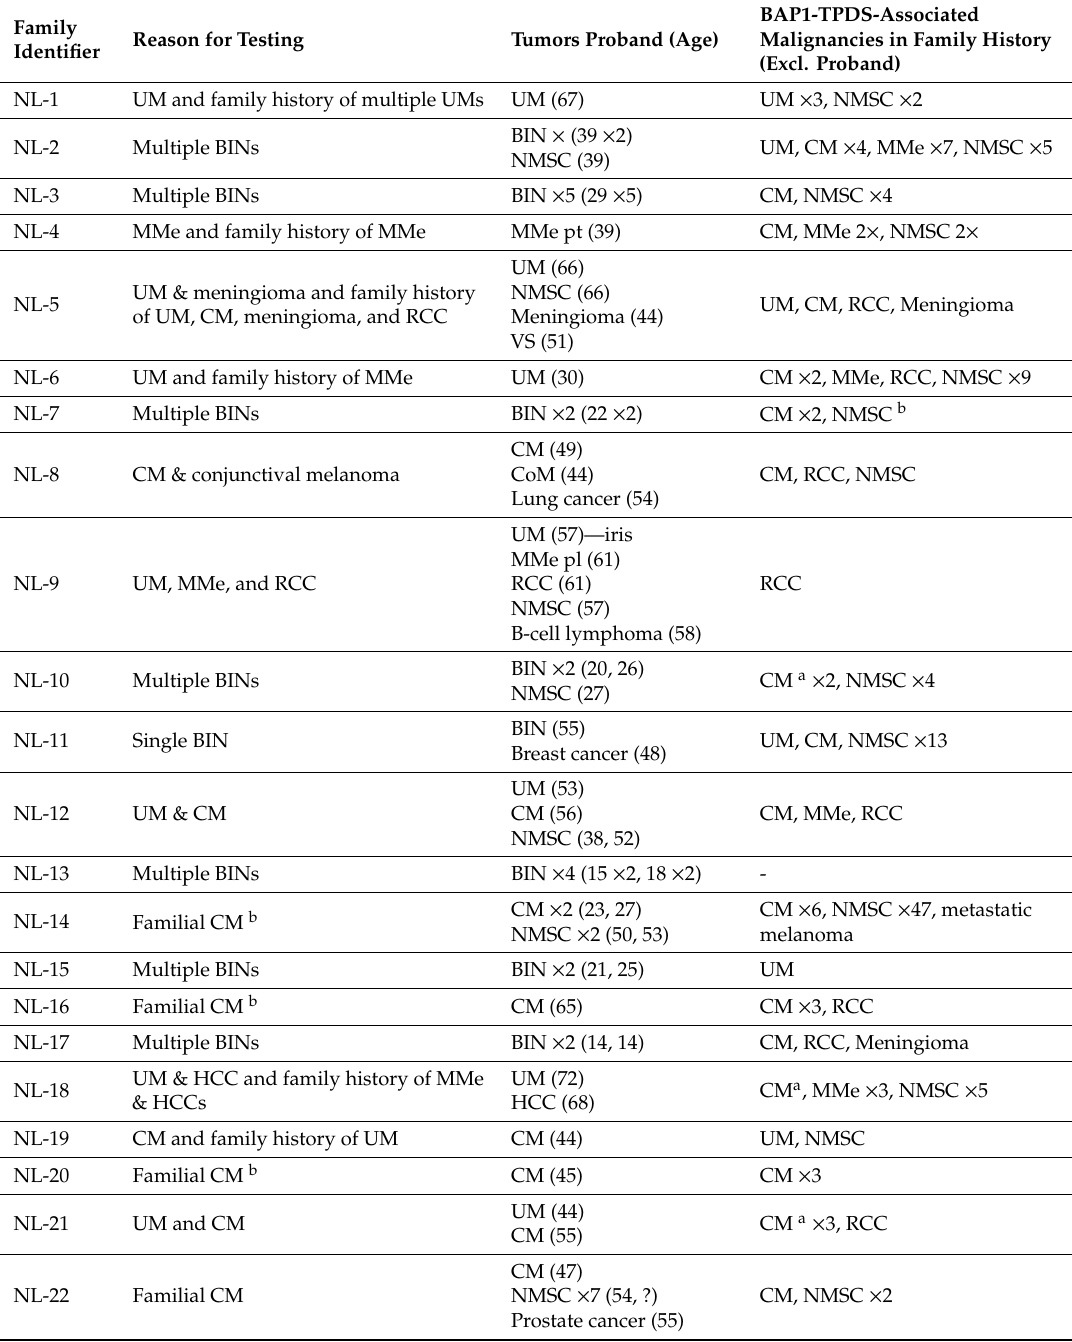
Table 1. The reason for genetic testing and the phenotype of BAP1-TPDS-associated malignancies in BAP1 -variant carriers in The